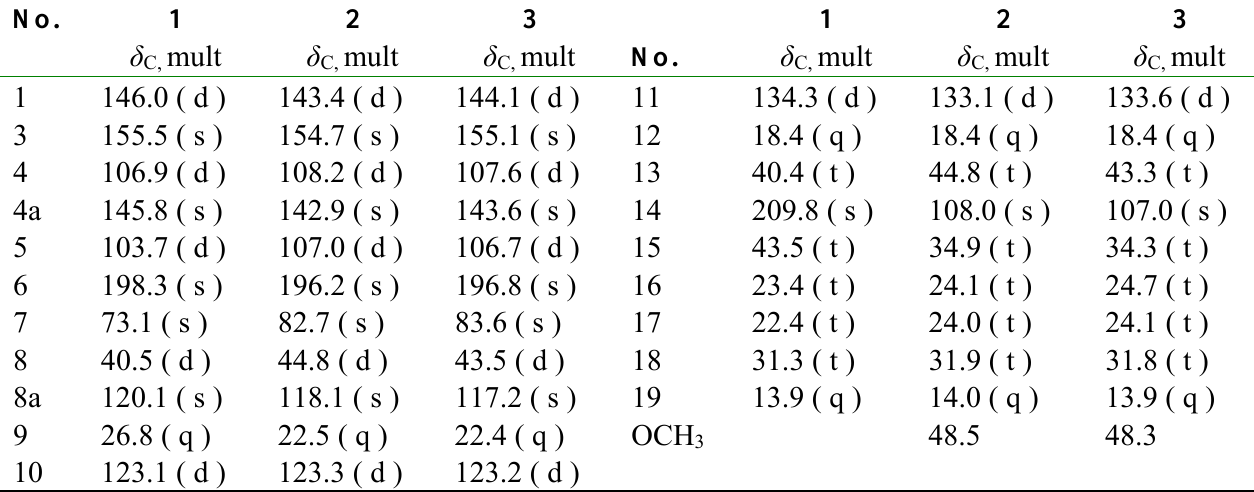
Table 2. 13 C-NMR data for compounds 1 - 3